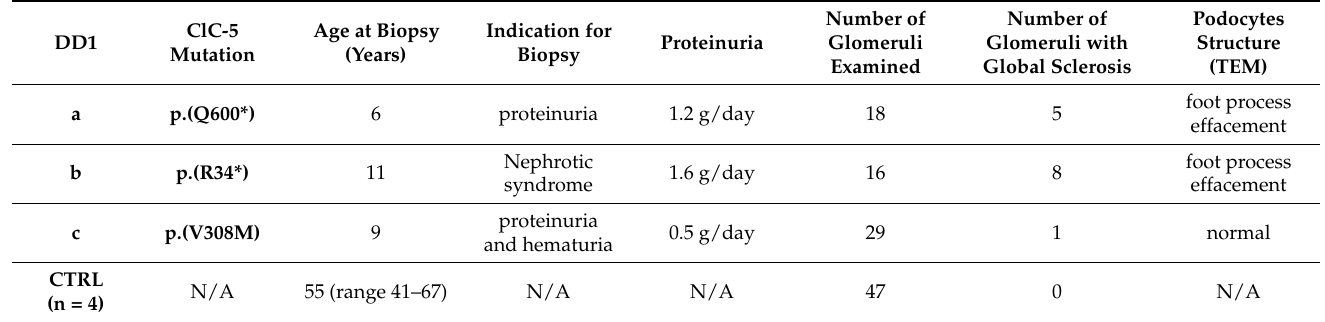
Table 1. Summary of histopathological and ultrastructural analyses of the three DD1 biopsies and the four control biopsies. CTRL: control biopsies TEM: transmission electron microscopy. N/A: not